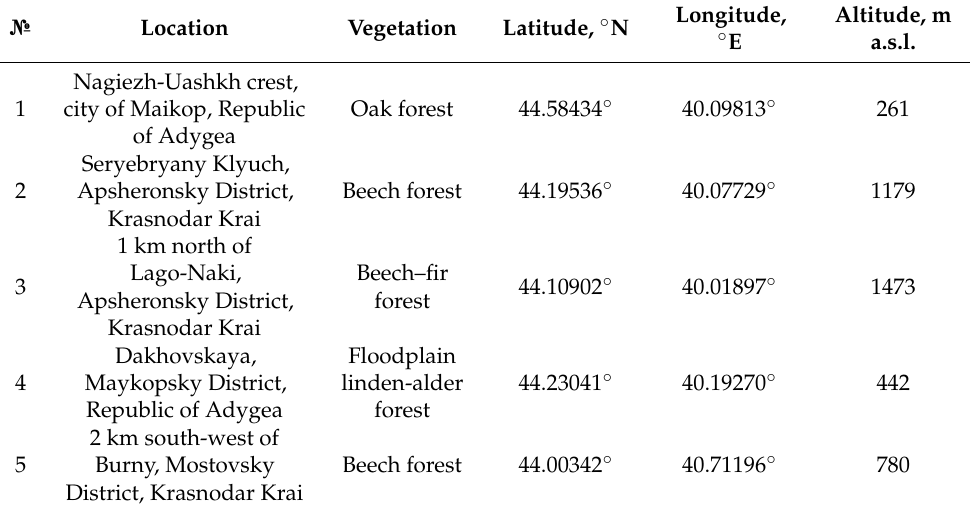
Table 1. Geographical and habitat data of the study localities in north-western Caucasus, Russia. № Location Vegetation Latitude, ◦ N Longitude,